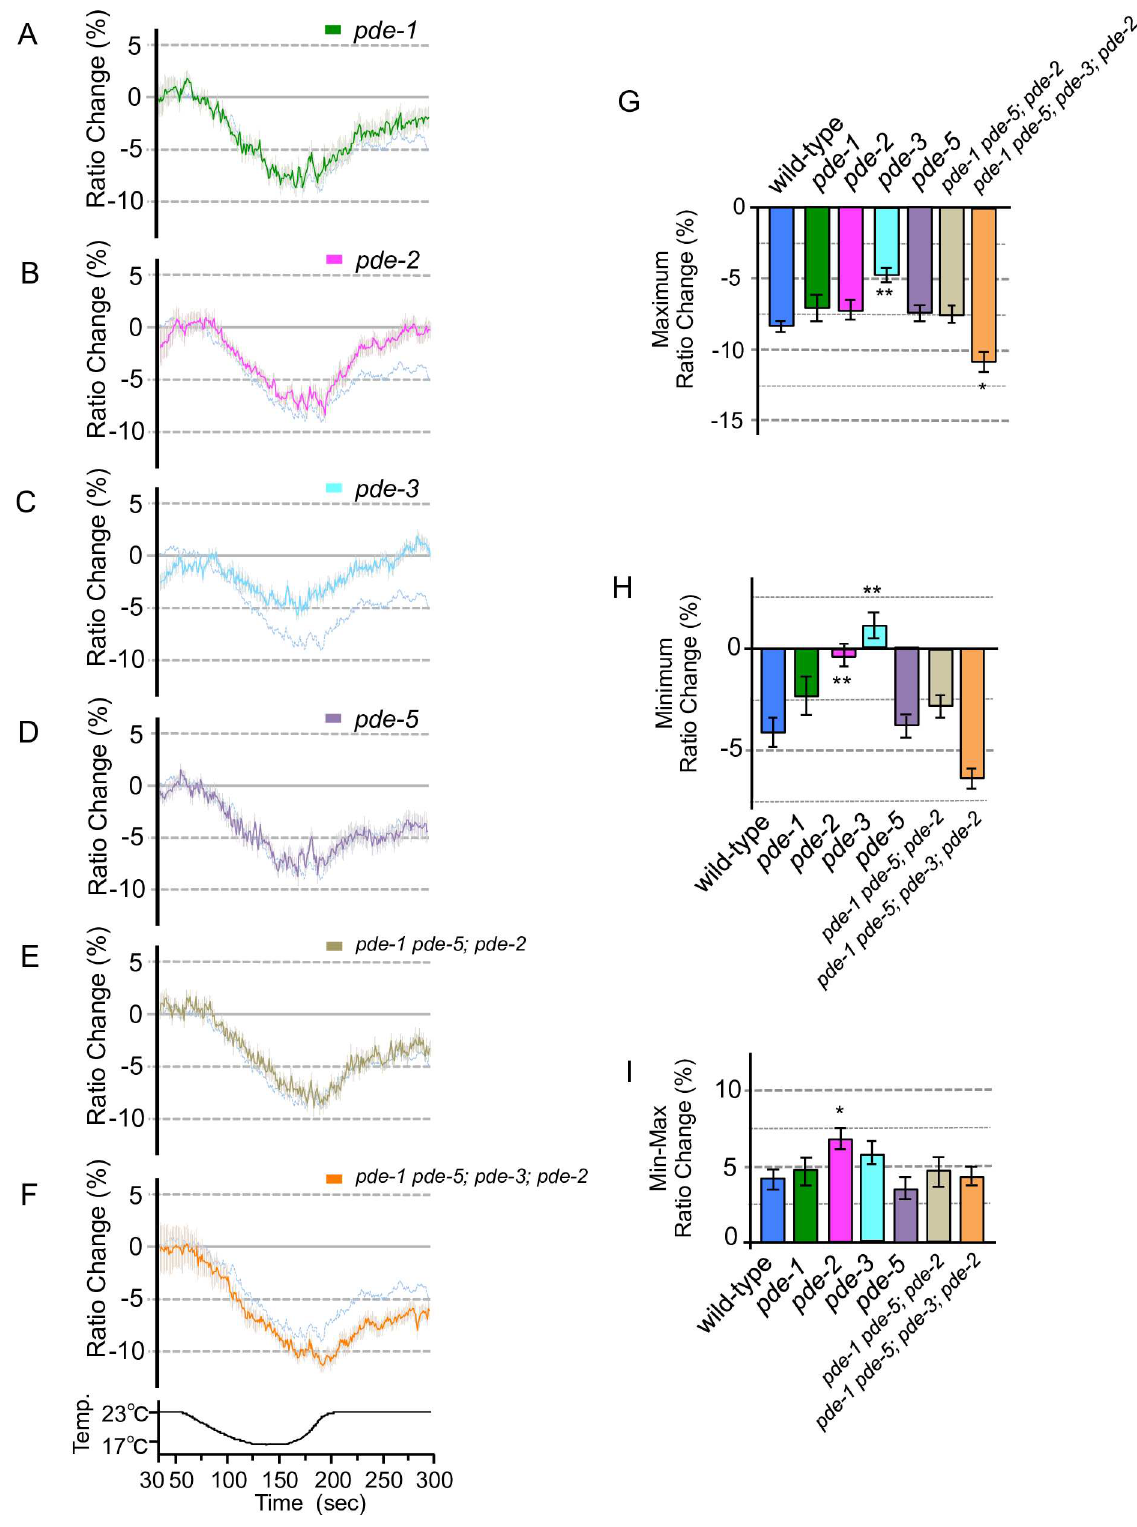
Fig 6. Calcium concentration changes in ASJ of PDE mutants with cooling stimuli. ASJ specificallyexpressing YC3.60 in wild-typeworms and PDE mutants. (A–F) we measured relative calcium concentrations under cooling stimuli as in the